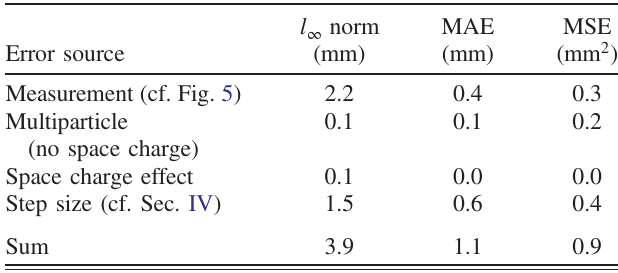
TABLE IV. Estimation of the lower bound of the error due to model simplifications and measurement